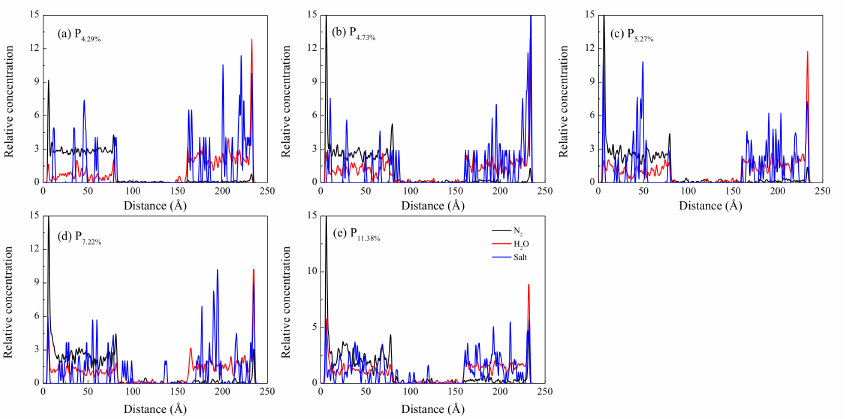
Figure 5. Relative concentration distribution of N 2 , H 2 O, and Salt along z-axis.